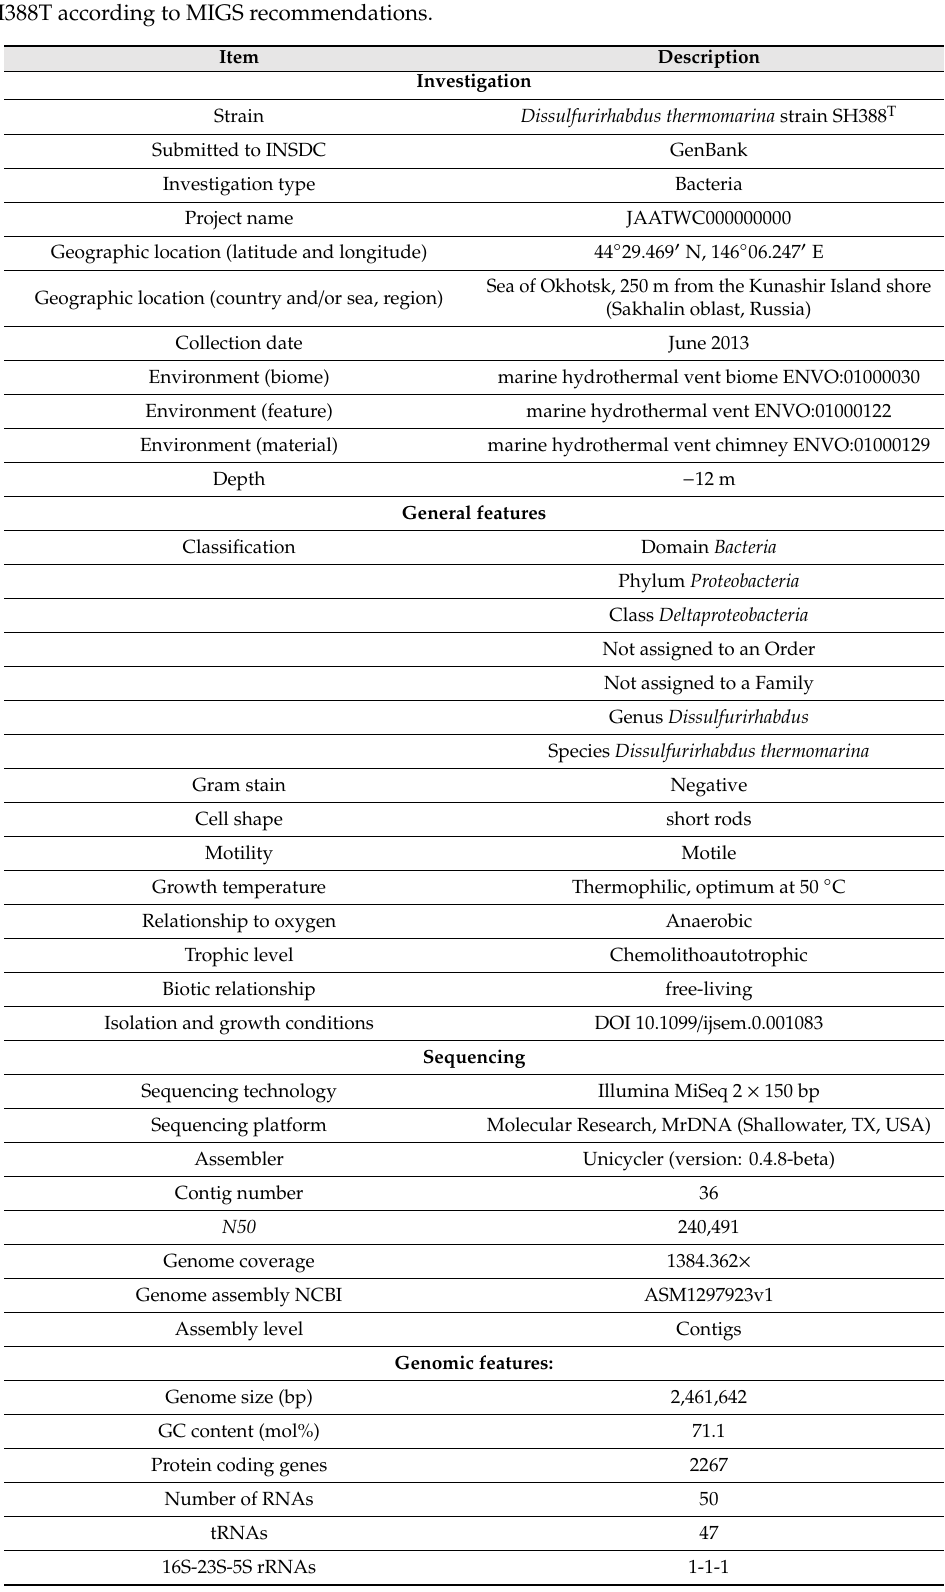
Table 1. General features and genome sequencing information for Dissulfurirhabdus thermomarina SH388T according to MIGS